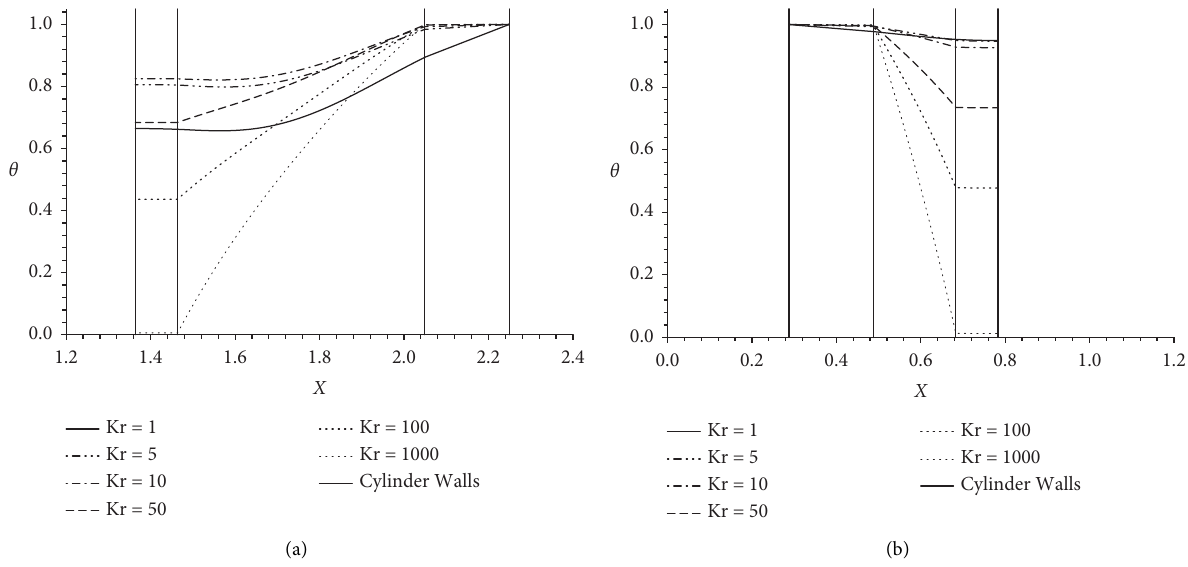
Figure 10: Temperature profiles across the channel, at the (a) widest and (b) narrowest gaps, at Z � 1.006 × 10 − 2 for different values of K (Case O), E � 0.5, χ 2 � 0.5, δ o � 0.2, δ i � 0.1.